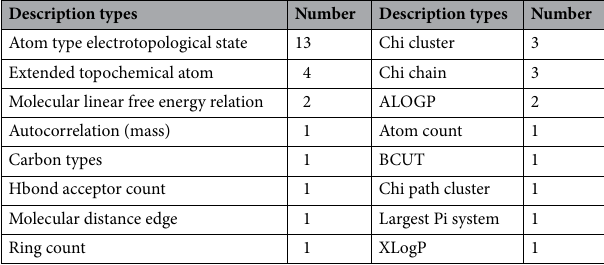
Table 1. Candidate molecular descriptor classification statistics.